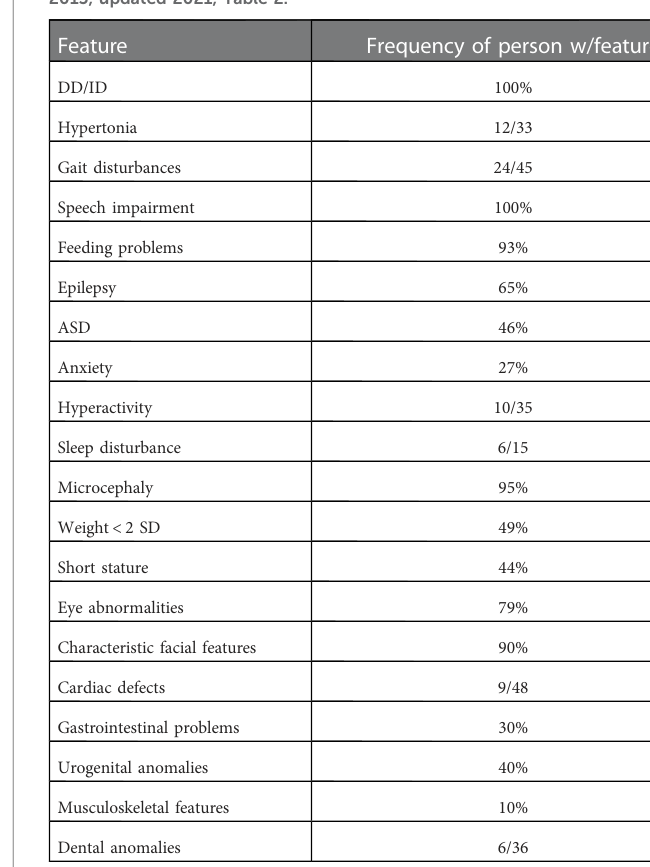
TABLE 1 Data from van Bon BWM, Coe BP, de Vries BBA, et al. In: Adam MP, Ardinger HH, Pagon RA, et al. DYRK1A syndrome . Published online March 17, 2015, updated 2021, Table